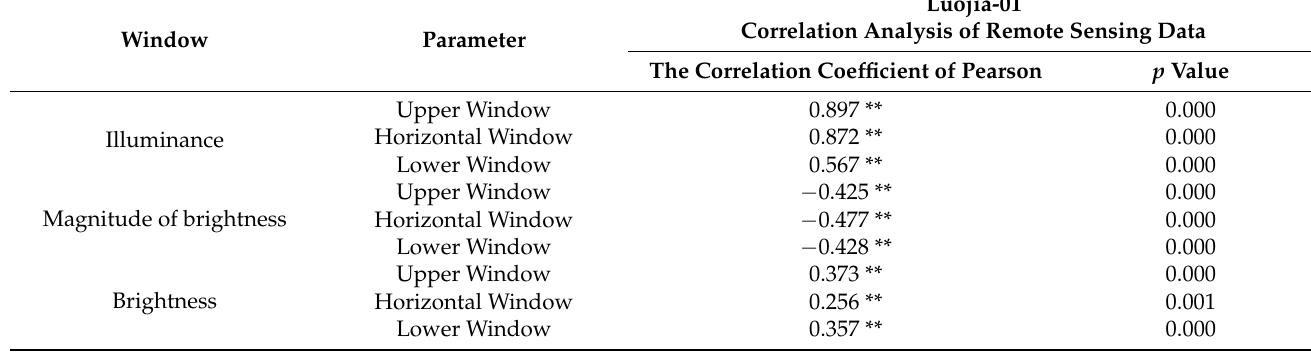
Table 1. Pearson analysis of illuminance data and remote sensing data.